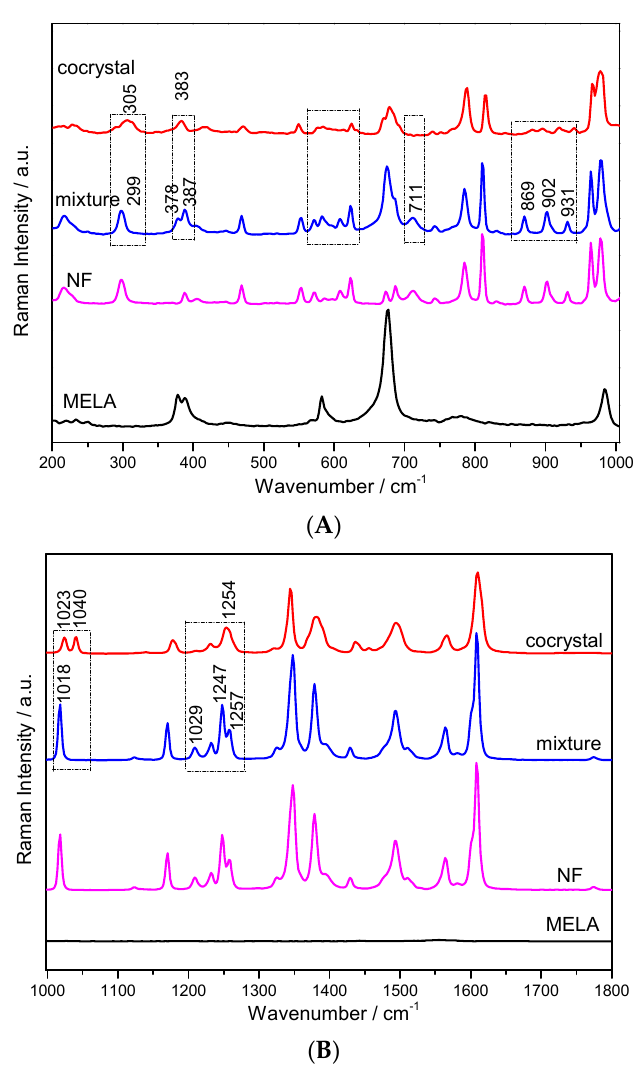
Figure 5. Raman spectra of NF, MELA, their physical mixture and the NF–MELA-hydrated co-crystal ranging from 200 to 1000 cm − 1 ( A ) and 1000 to 1800 cm − 1 ( B ).